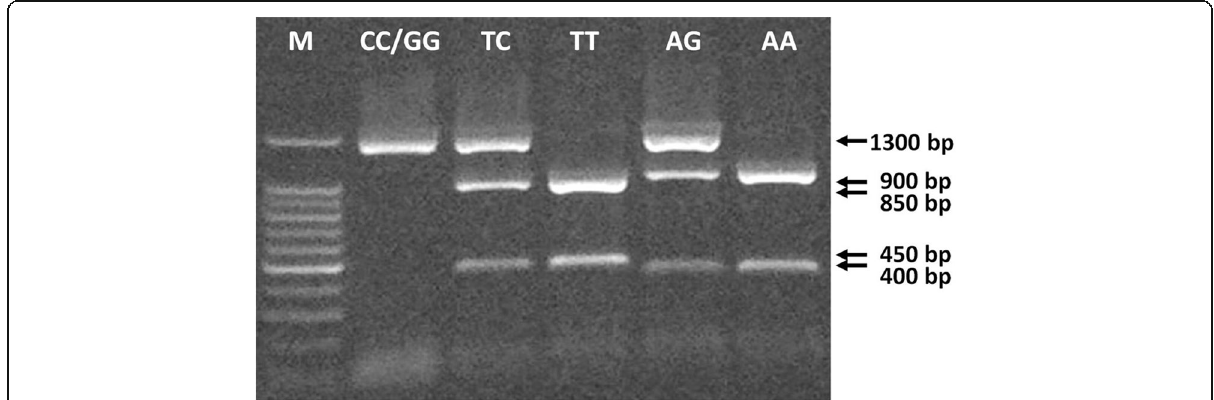
Fig. 1 Representative results of ESR1 genotypes detection. Lane M – 100 bp ladder; lane CC/GG – amplified ESR1 gene (1300 bp) and CC or GG genotypes; the other lanes represent combinations of DNA fragments related to the rest ESR1